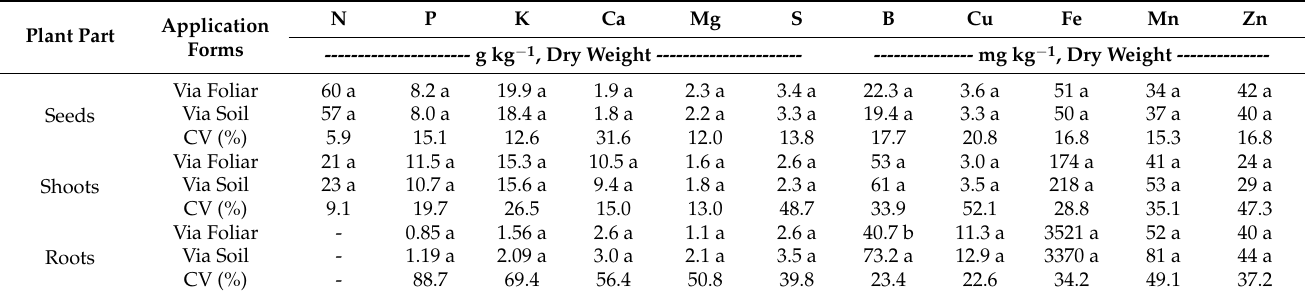
Table 2. Macro- and micronutrient concentrations in parts of soybean parent plants under foliar and soil Co and Mo application application, in the maturation phase, under controlled conditions.